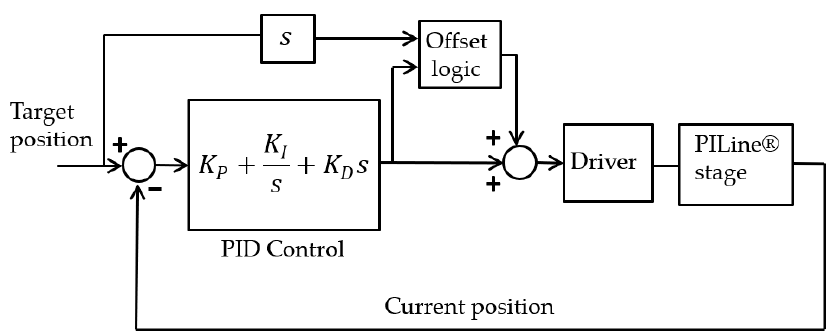
Figure 5. PID motion control algoritm of PILine ® stage.